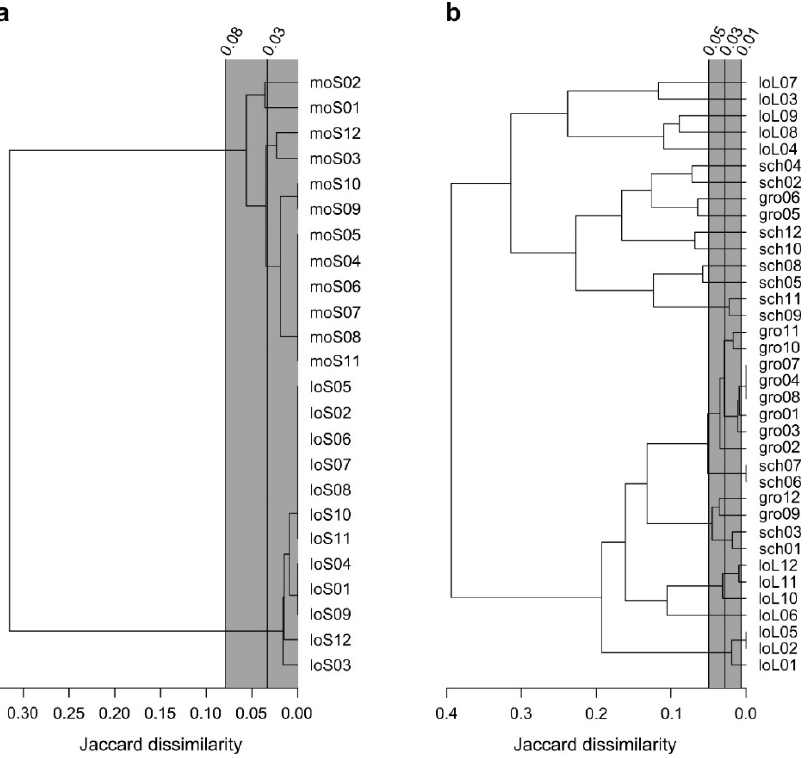
Figure 1. Average-linkage cluster analysis based on Jaccard dissimilarities for ( a ) Spirodela polyrhiza and ( b ) Lemna minor . Grey bar indicates mean Jaccard dissimilarity and its 95% confidence interval of the replicates. All samples separating to the left of the grey bar can be considered as different clones. The absolute Jaccard values are given at the top. lo = Lotschen, mo = Moscow, gro = Groeben, sch = Schloeben. S = Spirodela polyrhiza , L = Lemna minor . All samples from gro and sch are Lemna minor . Table 2. Distinct clones of the species Spirodela polyrhiza and Lemna minor and their origin by col- lected samples from ponds in Moscow, Lotschen, Groeben and Schloeben. For further explanations, cf. Table 1.